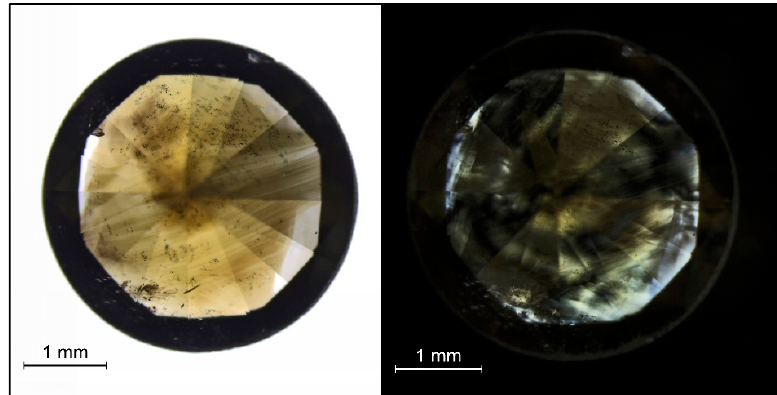
Figure 3. A very typical CO 2 diamond (TH 2.78) in immersion ( left ) and crossed polarizing filters ( right ). The brown color patch was shown to contain the CO 2 while the colorless sectors are free of CO 2 . The strain in CO 2 diamonds is not related to deformation, but most likely to micro-inclusions. Photos: Dr. Thomas Hainschwang.